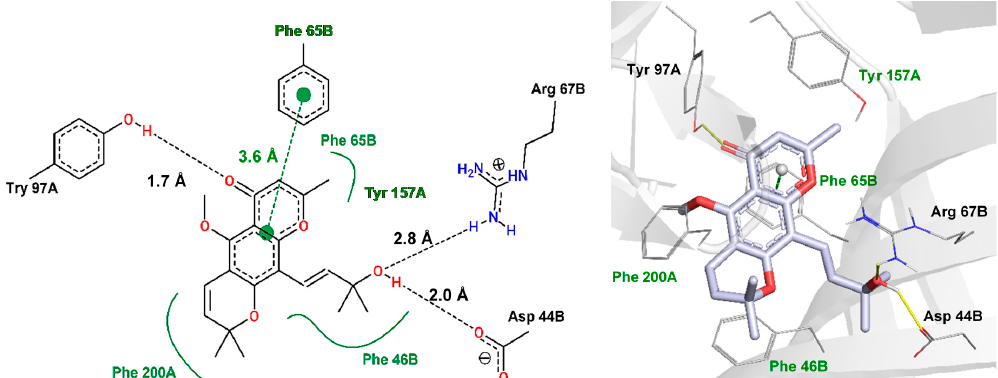
Figure 7. Interaction profile of 5-CK docked on bicuculline binding site (orthosteric binding site). The hydrogen bonds are displayed as black-dashed lines (two-dimensional (2D) view— left ) or yellow lines (three-dimensional (3D) view— right ), hydrophobic interactions as green lines (2D), and pi-stacking interaction as green-dashed line (2D). These interactions are not displayed in the 3D view, but the equivalent amino acids are labeled in green. The red and blue sticks (3D) represent oxygen and nitrogen atoms, respectively. Distances are measured in angstroms (Å). The interaction pattern was generated with Poseview (2D) and PLIP (3D)